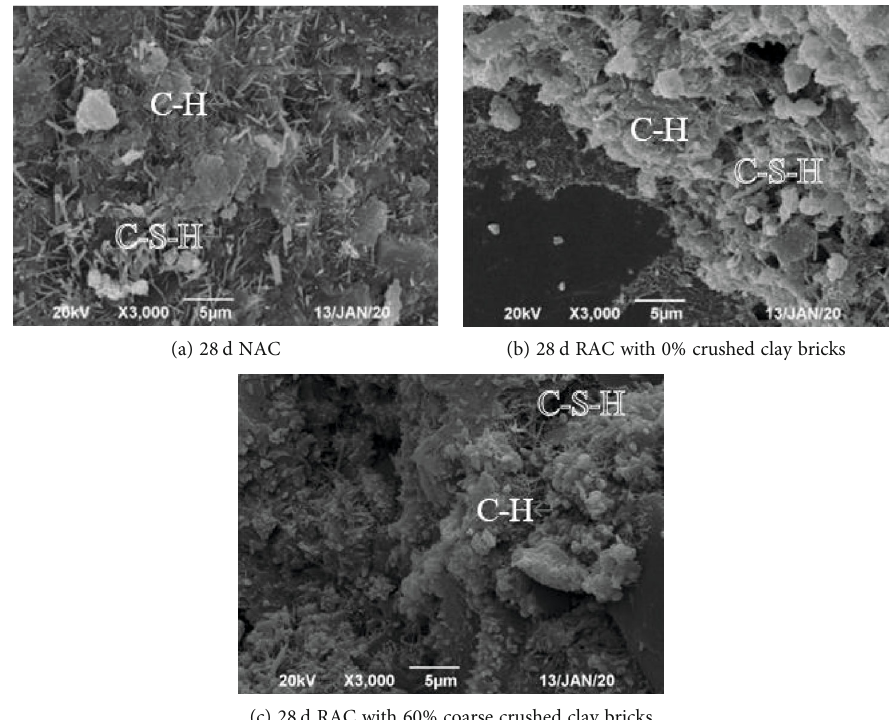
Figure 9: Microscopic morphology of NAC and RAC with 0% or 60% coarse crushed clay bricks at the age of 28d (magni fi ed 3000 times).